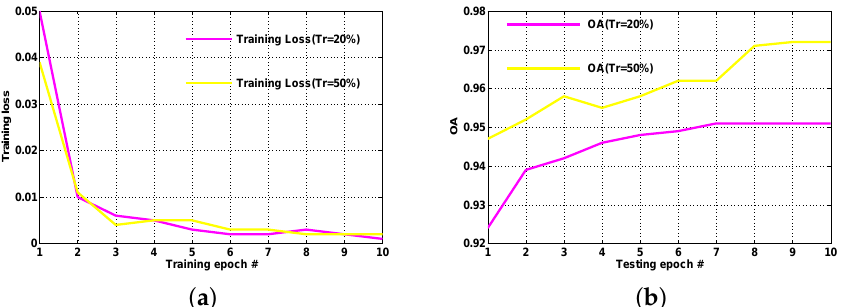
Figure 13. ( a ) Training loss of each epoch on AID dataset. ( b ) Corresponding OA of each epoch on AID